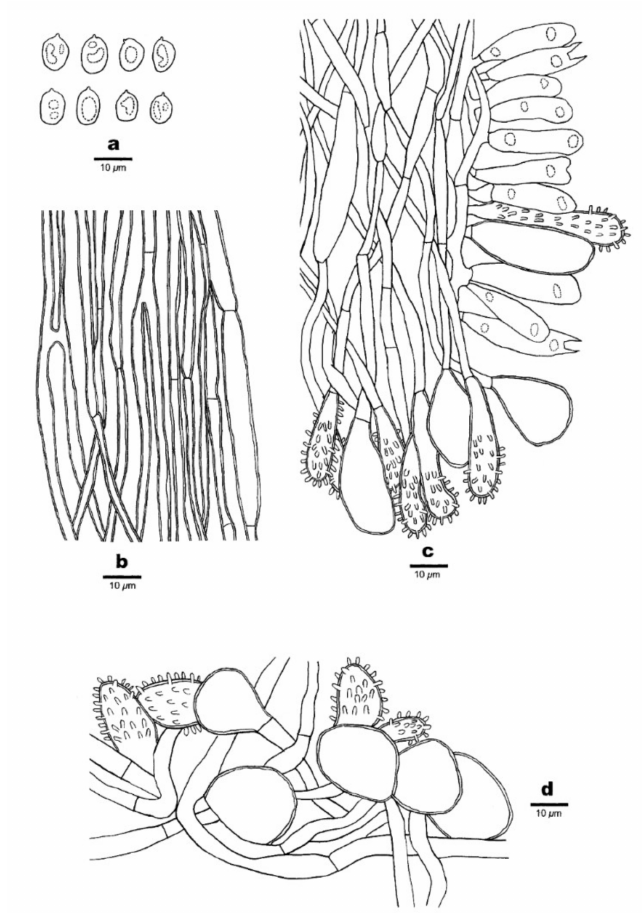
Figure 15. Microscopic structures of Favolaschia minutissima (Dai 20086, holotype). ( a ) Basidiospores. ( b ) Medullary hyphae of the stipe. ( c ) Hyphae at the edge of pores showing gloeocystidia, acantho- cystida, basidia, and basidioles. ( d ) Hyphae of the pileus cortex, composed of a hymeniform layer of acanthocysts and